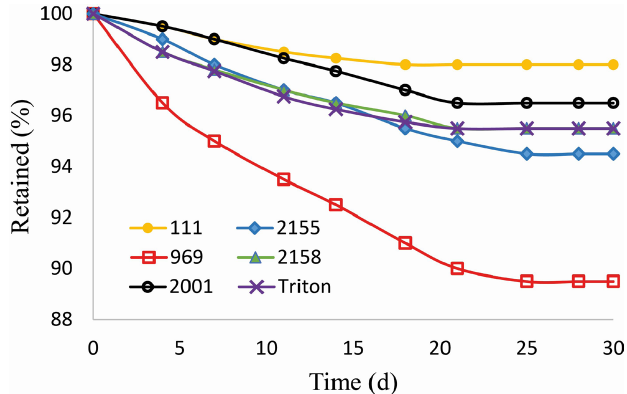
Figure 6. Sedimentation test of ceramic slurries with 15 vol% solid loading with different dispersants: Retained volume fraction as a function of the time.